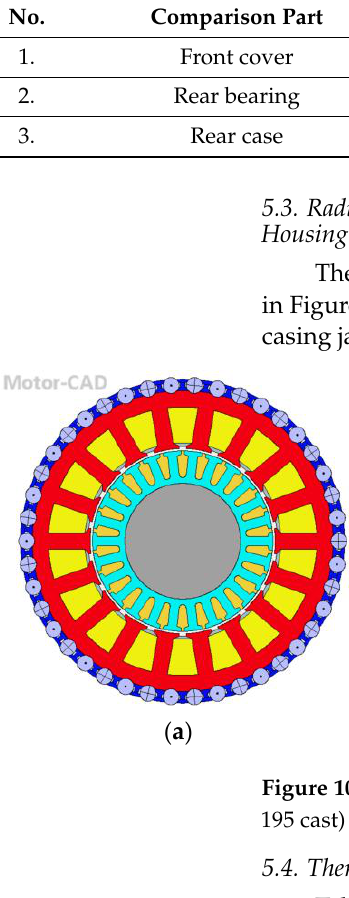
Table 8. Input parameters for thermal analysis on water-cooled motor with aluminum casing (AN- SYS Motor-CAD). No.